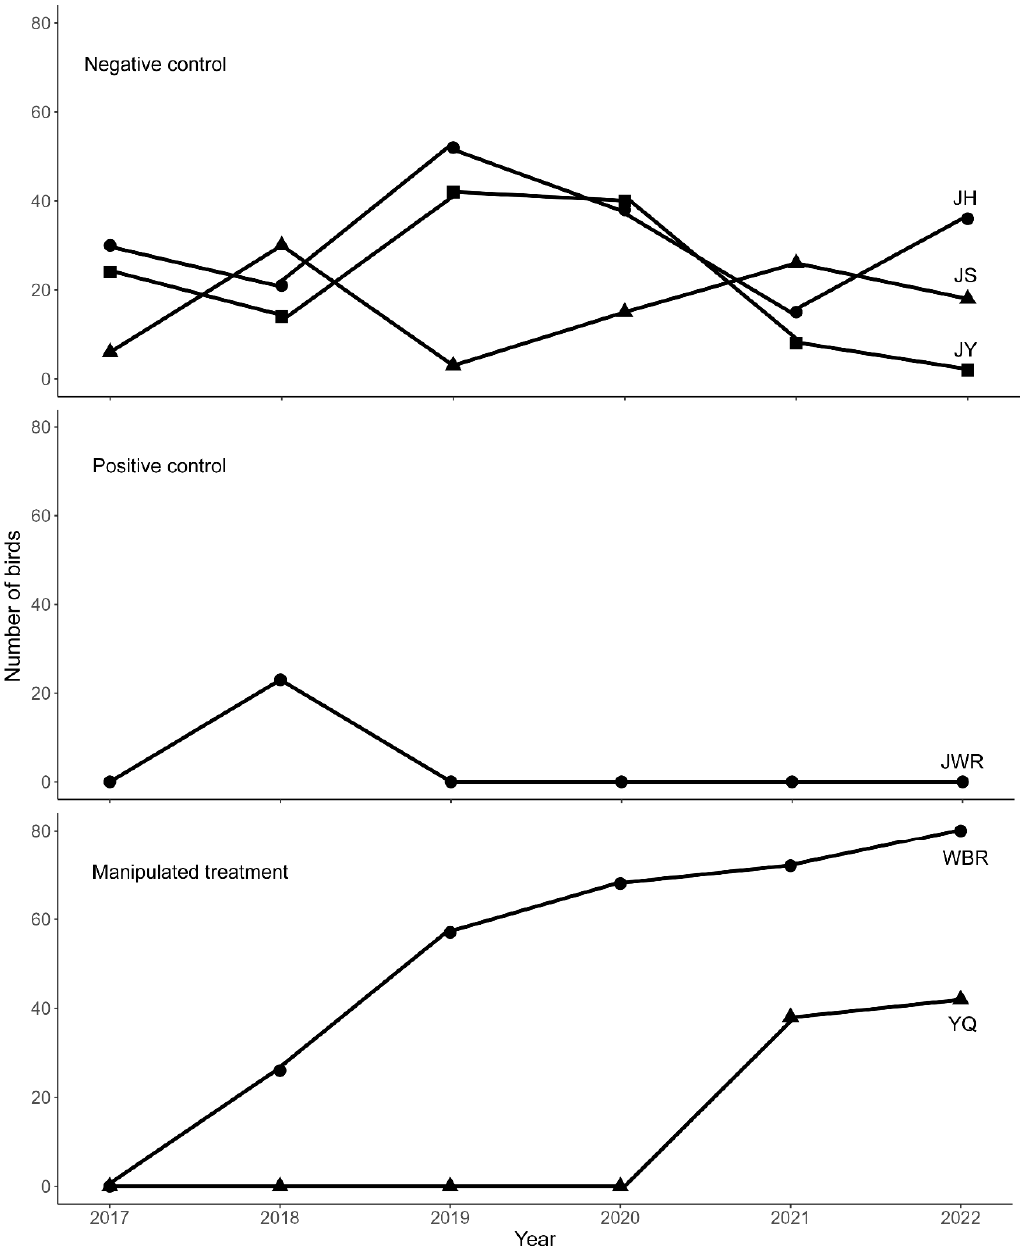
Figure 3. Number of blue-tailed bee-eaters ( Merops philippinus ) recorded at the six study sites during the breeding season from 2017 to 2022. JH: Jinhui; JY: Jinshawanyi; JS: Jinshawansi; JWR: Jinshawan Wetland Reserve; YQ: Yongqing; WBR: Wuyuanhe Bee-eater Reserve.